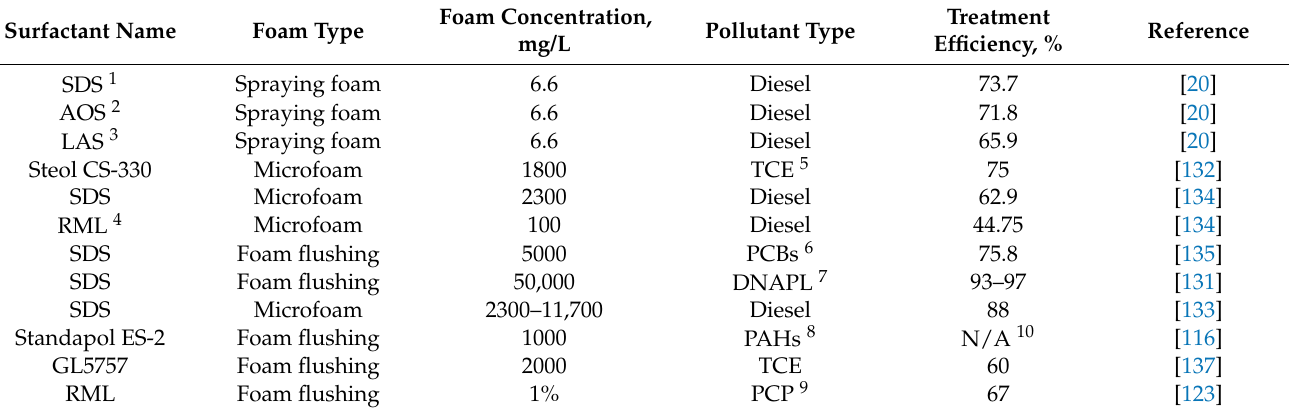
Table 4. Use of anionic surfactant foam for treatment of oil from contaminated Table 4. U se of anionic surfactant foam for treatment of oil from contaminated soil.